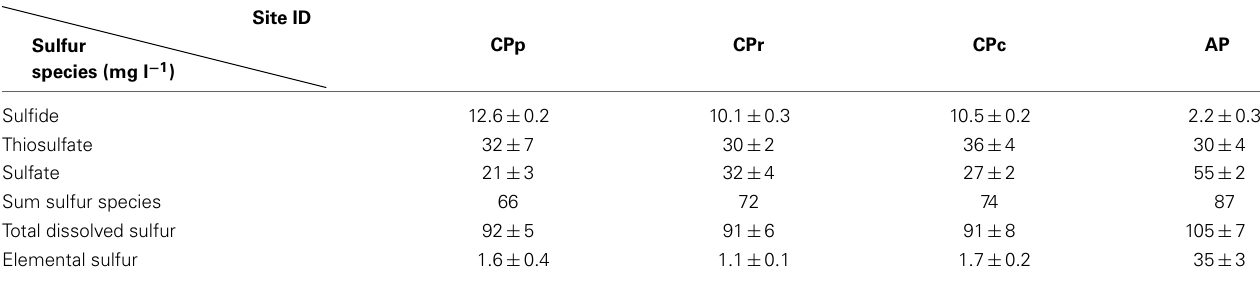
Table 3 | Sulfur speciation and total dissolved sulfur concentrations in Champagne